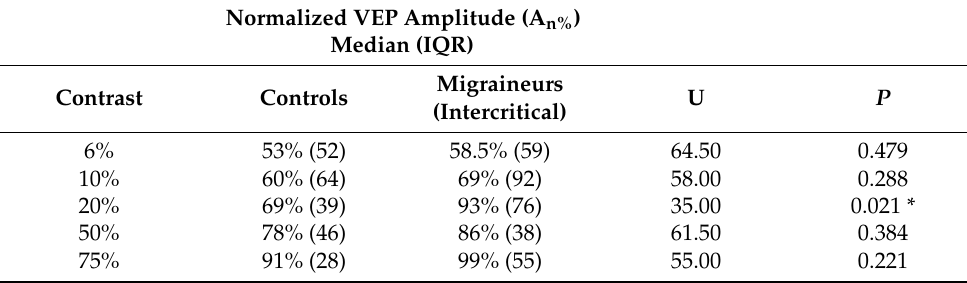
Table 4. The normalized amplitude at single contrast confronting migraineurs (during the intercritical period) and